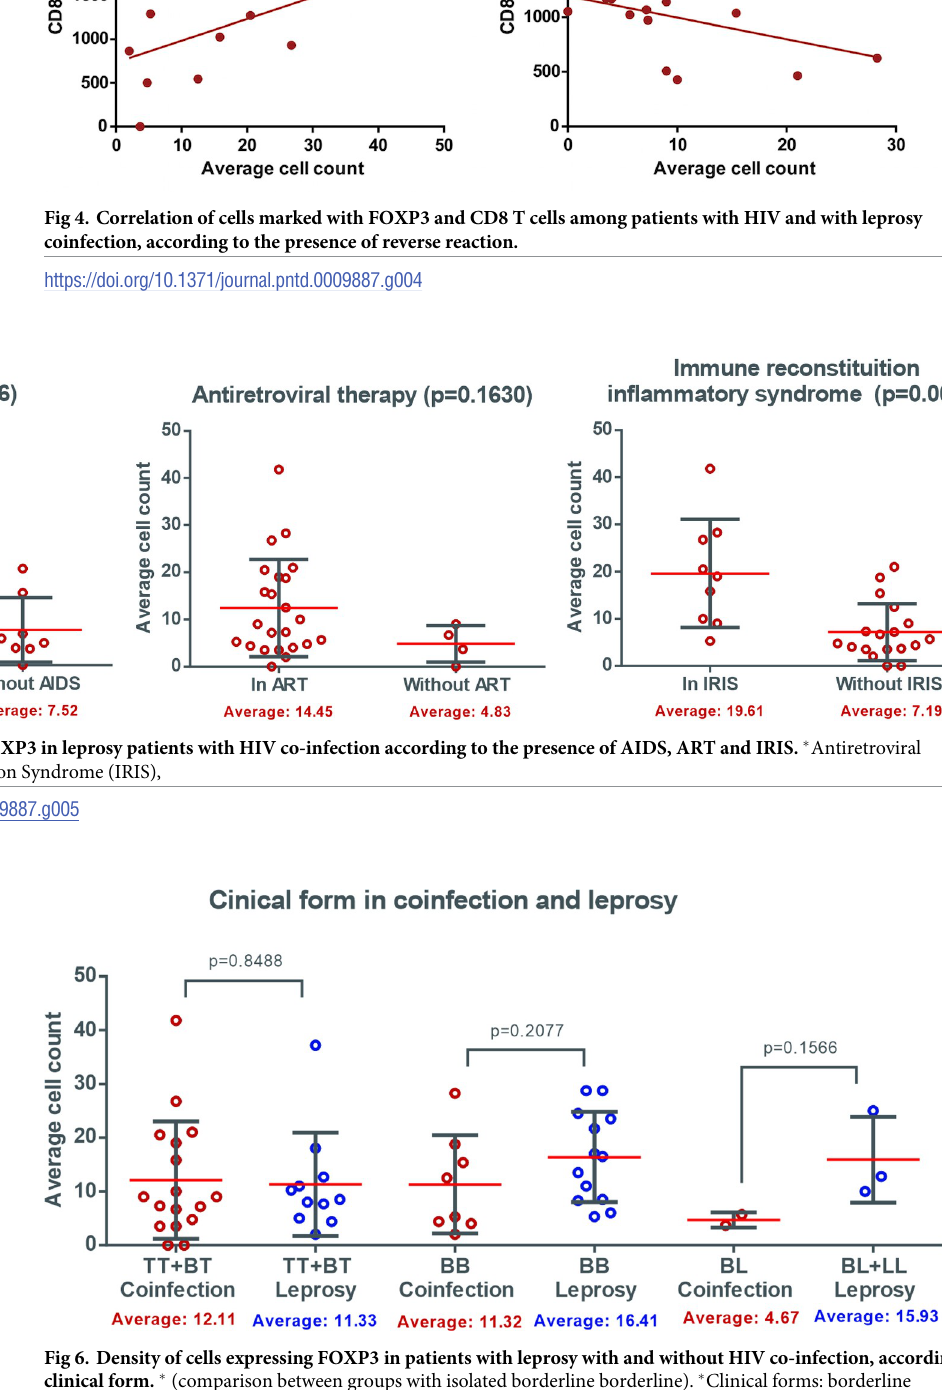
PLOS NeglectedTropical Diseases | https://doi.org/10.1371/journal.pntd.0009887 November8,